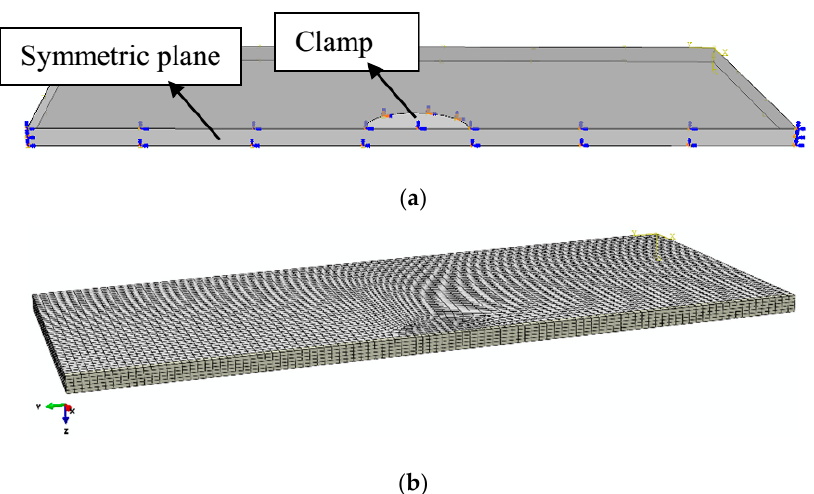
Figure 3. ( a ) Model with the clamp; and ( b ) the computational mesh used for 3D with plane-symmetry finite element